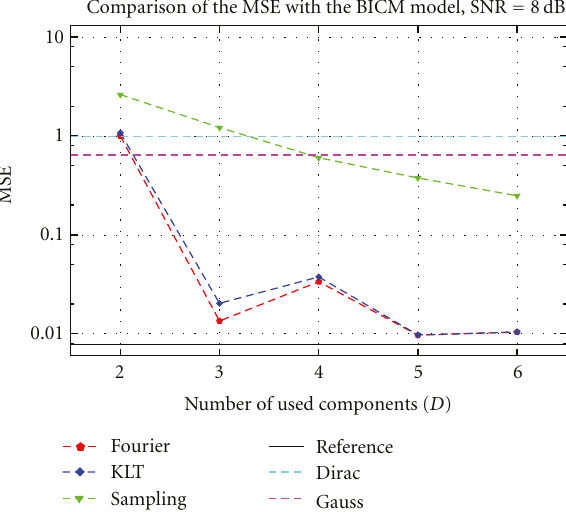
Figure 8: MSE of the phase estimation as a function of dimension for various message representations.